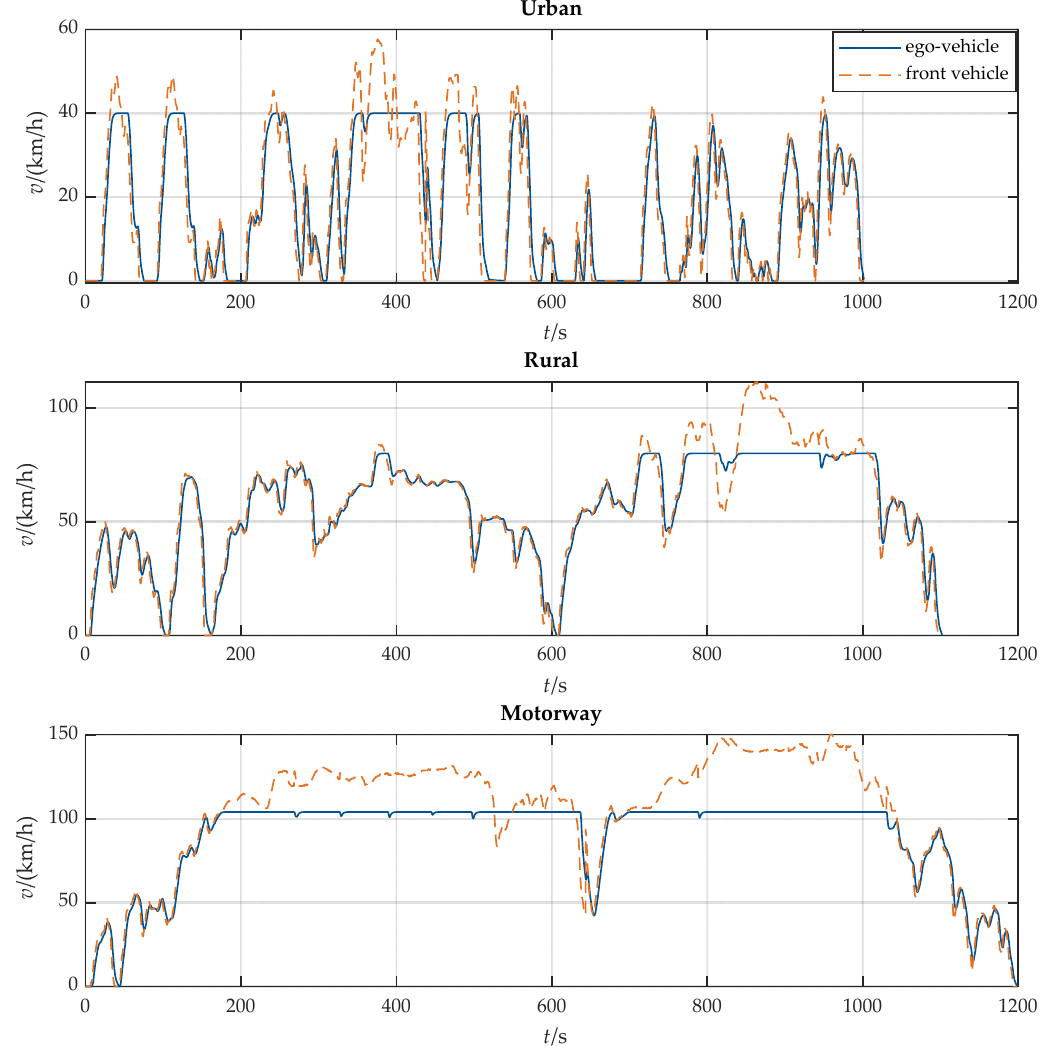
Figure 16. Driving cycles for the comfortable driving style.